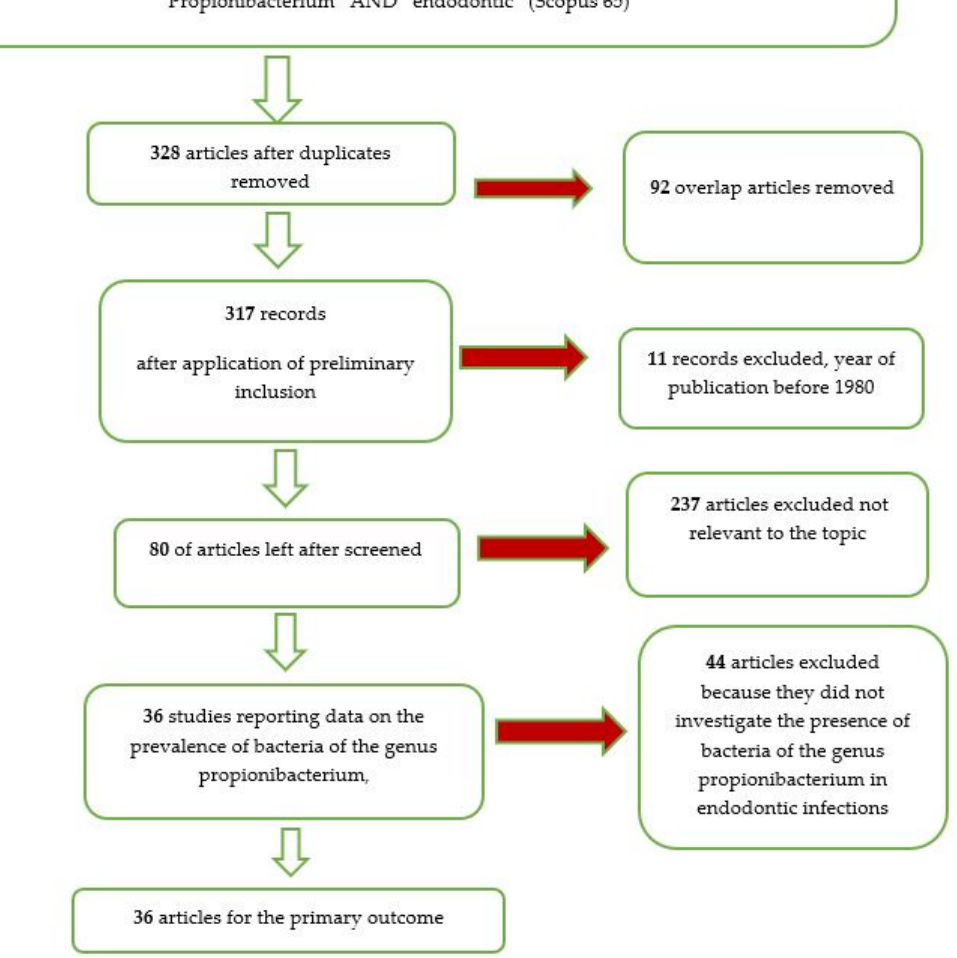
Figure 1. Flow chart of the different phases of the systematic review.